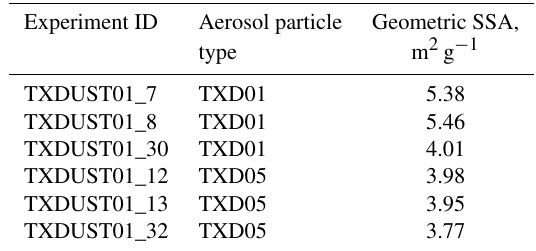
Table 4. Geometric SSA values for individual AIDA expansion ex-